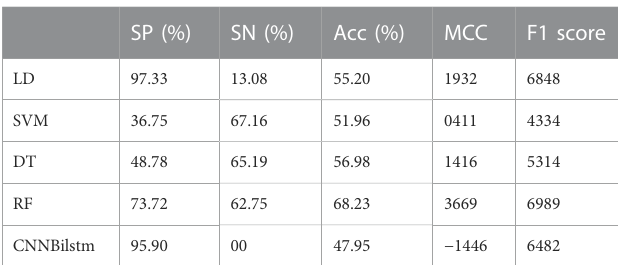
TABLE 5 The performances of DDE